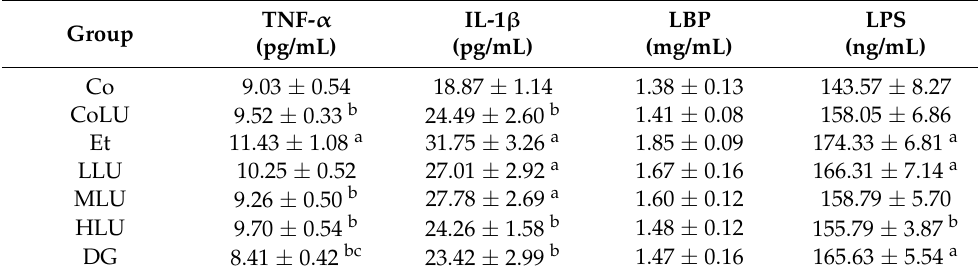
Table 4. Effects of lutein on levels of inflammatory cytokines.